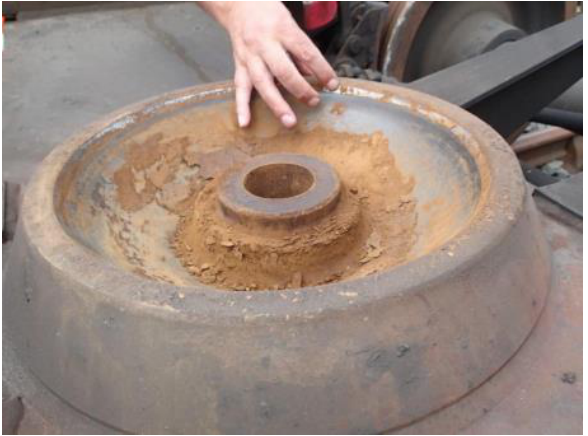
Figure 1. View of worn friction liner in the center bowl. Adapted from [8].